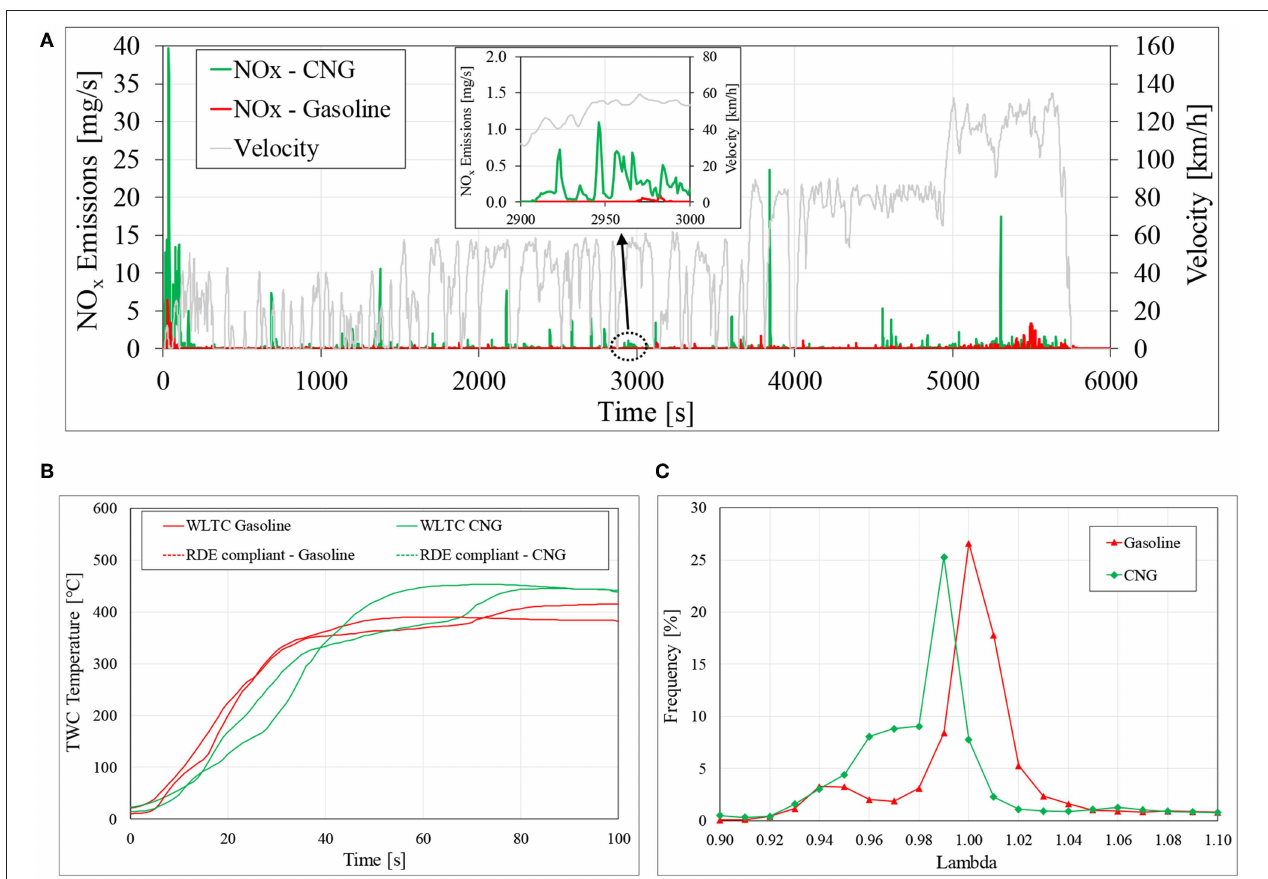
FIGURE 11 | (A) Instantaneous NO x emissions of Vehicle 2 with gasoline and CNG during the RDE-compliant test. (B) TWC temperature evolution in WLTC and RDE-compliant tests. (C) Distribution of lambda (air-fuel equivalence ratio) during the RDE-compliant